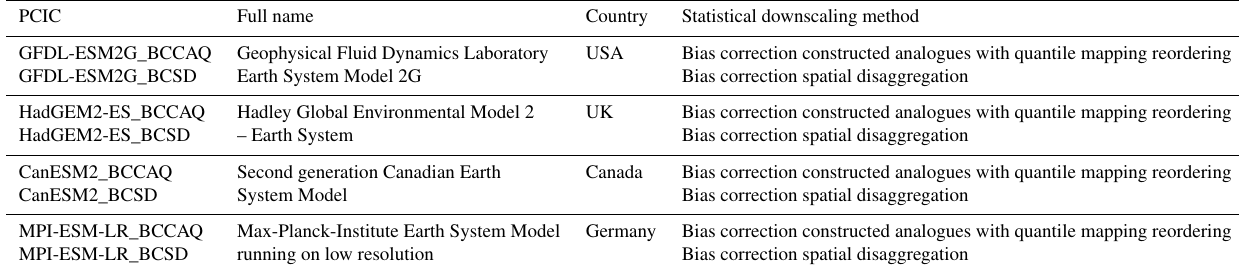
Table 2. Global circulation models (GCMs) chosen in the Pacific Climate Impacts Consortium (PCIC) dataset.